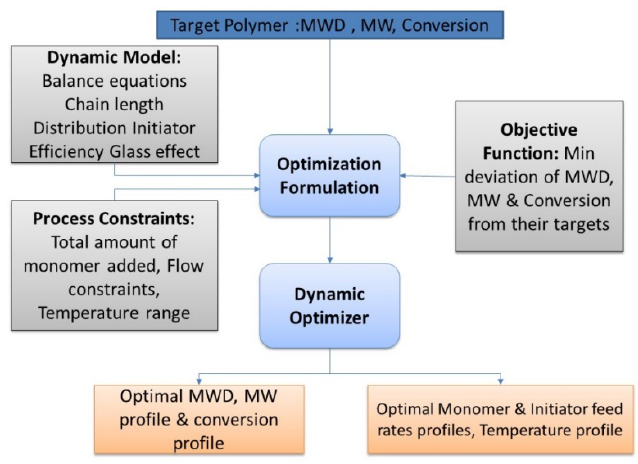
Figure 2. Schematic representation of the optimization problem in polymerization processes.